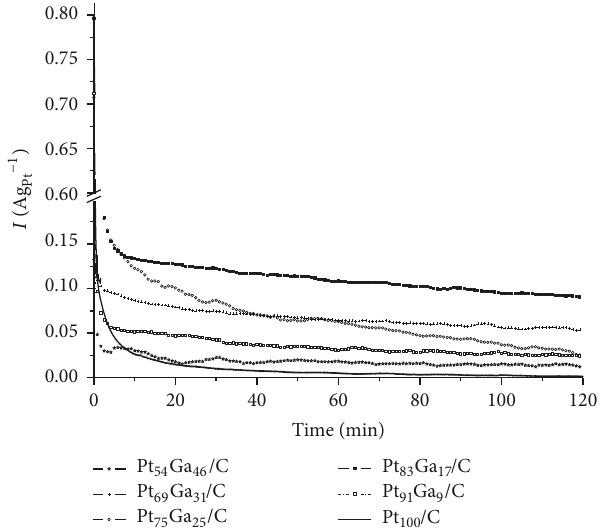
Figure 8: Current versus time plots for the electrooxidation of 1.0mol L −1 ethanol in H 2 SO 4 0.5 molL −1 at 0.4V versus RHE on various PtGa/C